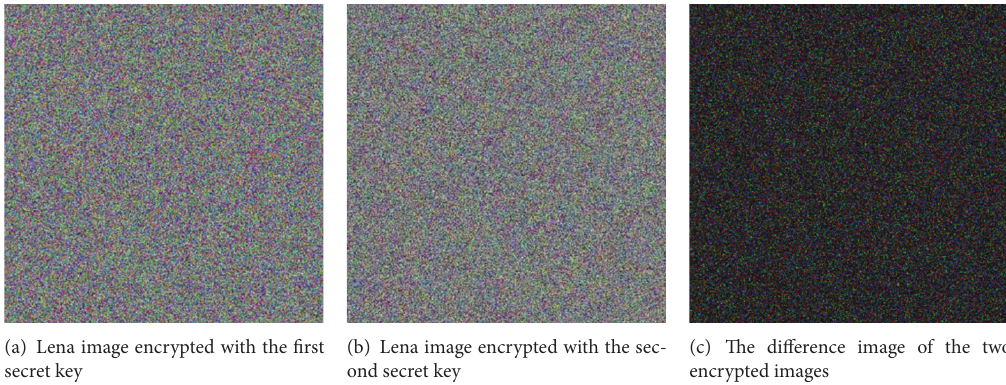
Figure 7: Images that resulted from encrypting the Lena image using two secret keys which differ by 10 −12 on a single double data type component.